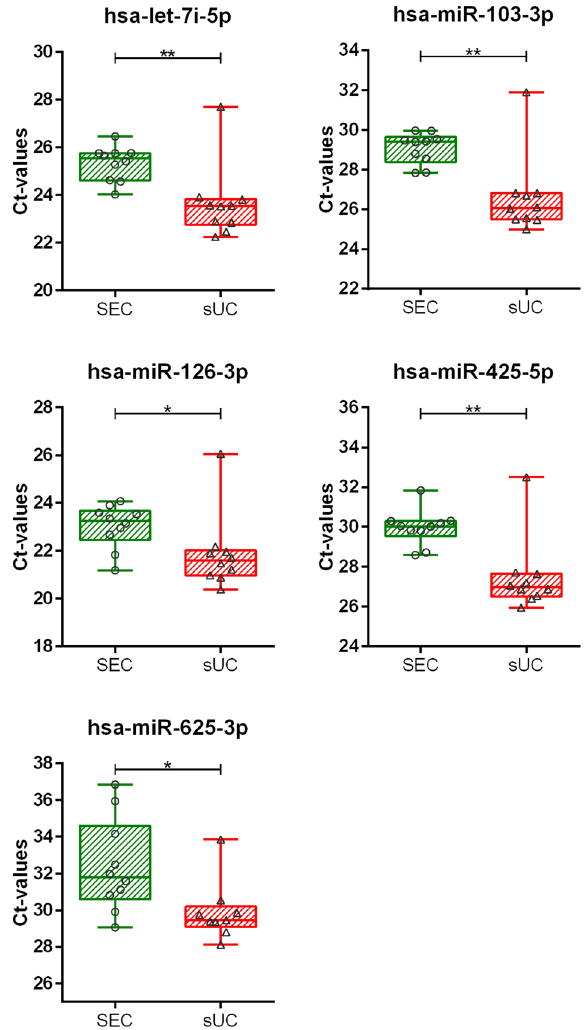
Figure 3. Quantification of enriched nanoparticles from human blood plasma by qPCR. Ct values of five selected miRNAs in samples after sUC and SEC. Each square or circle presents one sample. N = 10. * p < 0.05, ** p < 0.01. Ct cycle threshold, sUC sucrose cushion ultracentrifugation, SEC size exclusion